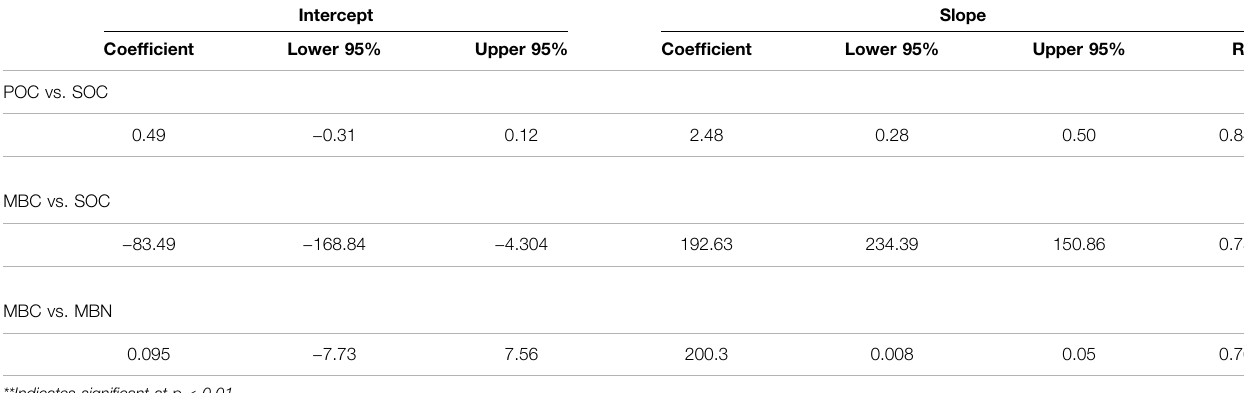
**Indicates signi fi cant at p < 0.01.